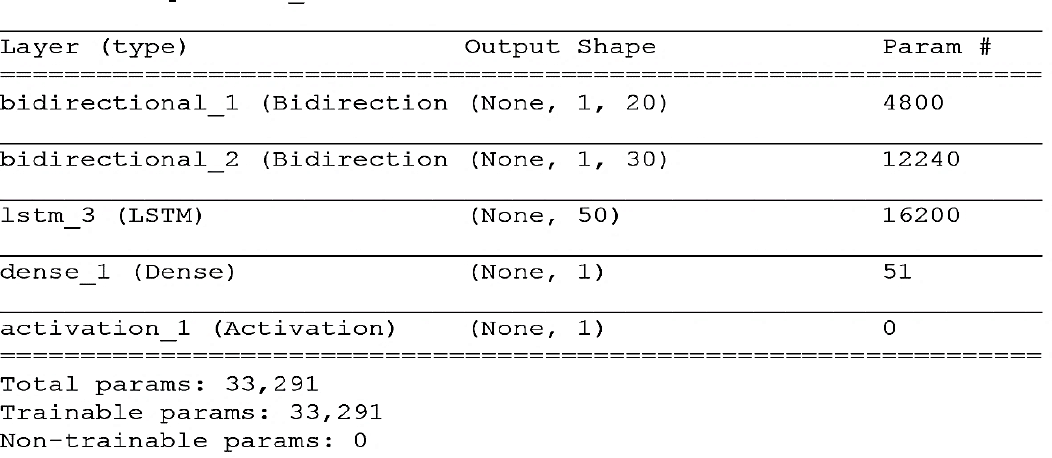
Figure 7. A snapshot taken within the BiLSTM model development phase; it shows the layers through which the information flows for learning in the network.